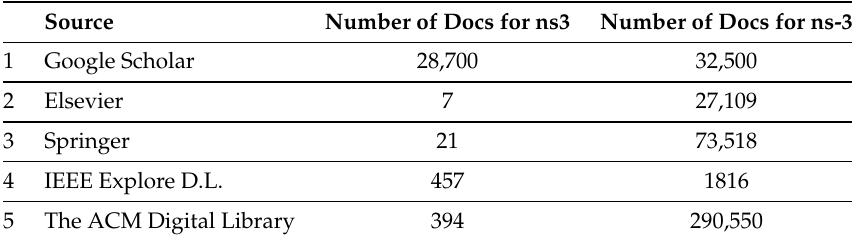
Table 3. Documents retrieved for research keywords and source